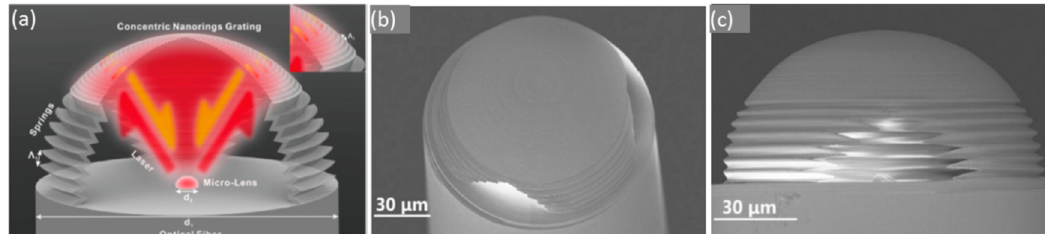
Figure 17. ( a ) 3D design of the microcavity with the micro lenses to implement the optical fibre microphone; ( b ) detailed of the top view of the cavity and ( c ) its side view, where the lens can be seen. Images reprinted from [67] with permission of Elsevier.